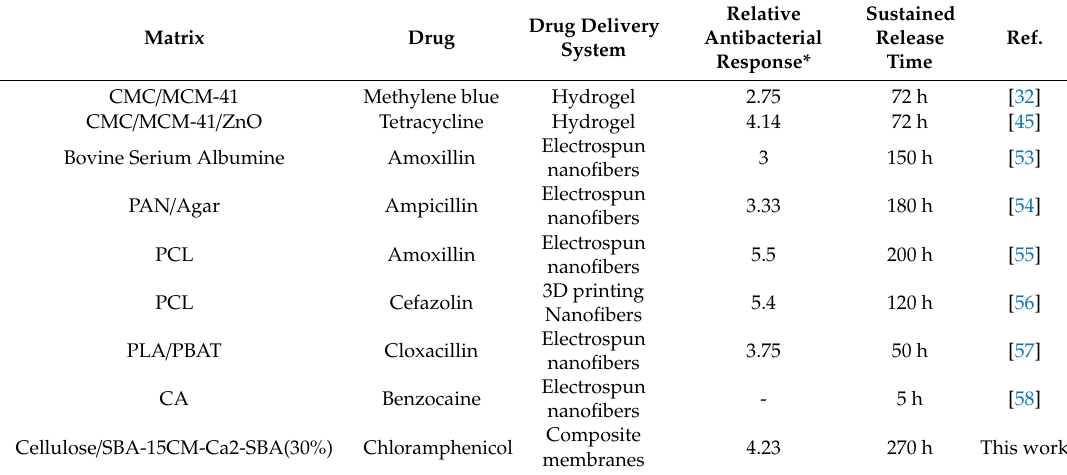
Table 2. Comparison of drug delivery systems in the